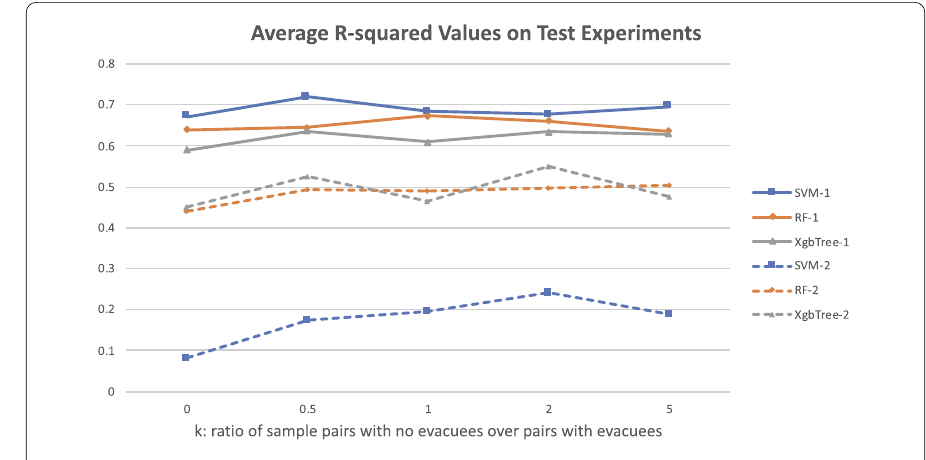
Figure 7 Averaged R-squared values over repetitive experiments